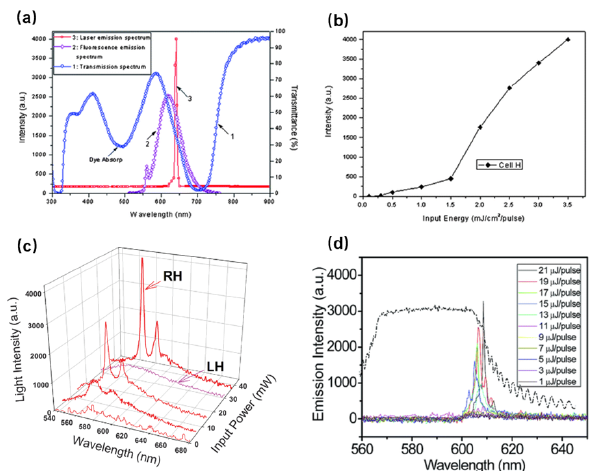
Figure 3. ( a ) Transmission spectrum, fluorescence emission spectrum and laser emission spectrum; ( b ) The dependence of the emission intensity on the excitation light intensity; Reprinted with permission from Ref. [61]. Copyright 2010 Royal Society of Chemistry. ( c ) The laser emission spectrum at different continuous wave (CW) pumping powers. Reprinted with permission from Ref. [62]. Copyright 2012 The Optical Society. ( d ) The fluorescence emission spectrum of the quantum dot CLC polymer template with pumped energy, and corresponding reflection spectra (dashed